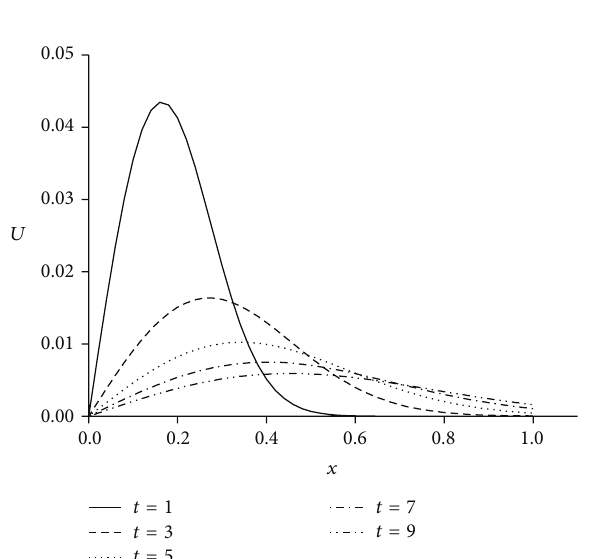
Figure 4: Solutions for V = 0.01 , ℎ = 0.02 , Δ𝑡 = 0.01 , and 0 ≤ 𝑥 ≤ 1